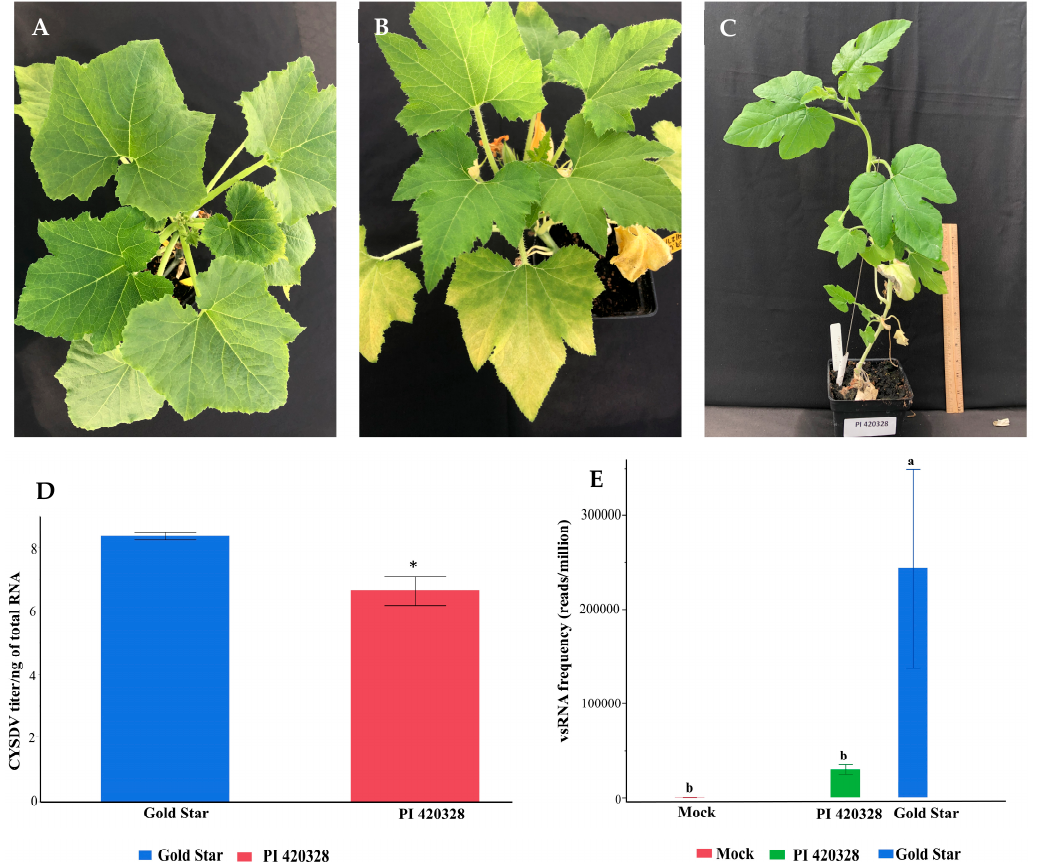
Figure 1. Impact of CYSDV infection on squash line Gold Star and PI 420328, 30 days after inoculation: ( A ): mock-inoculated plants with non-viruliferous whiteflies displayed no phenotypic symptoms; ( B ): Gold Star developed prominent interveinal chlorosis and yellowing; ( C ) PI 420328 only displayed yellowing symptoms on the lower leaves; ( D ) estimated copy numbers of CYSDV in Gold Star (blue) and PI 420328 (red) at 30 DAI. Viral titer is represented as the mean Log concentration per ng total RNA. Each value is the average of three biological replicates with standard error bars; * indicates a significant difference ( p < 0.05); ( E ) number of CYSDV-derived vsRNA reads per million total reads averaged over three replicates. Levels not connected by the same letter are significantly different (Student’s t -test, p < 0.05).